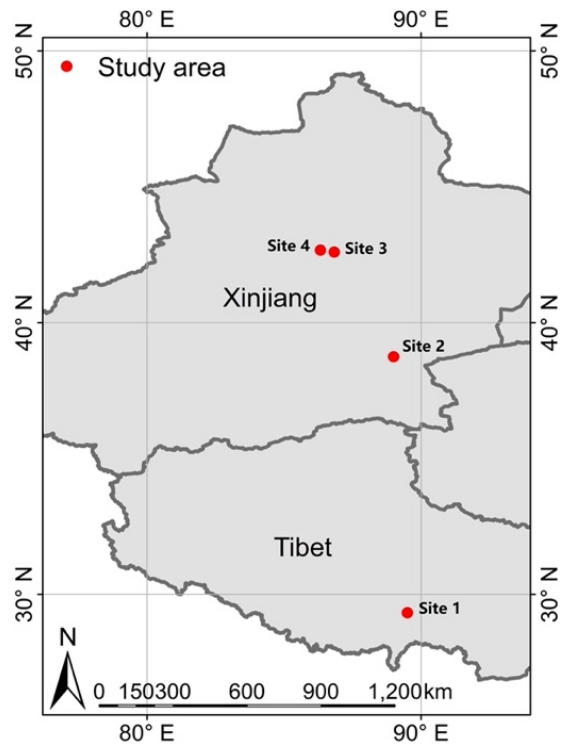
Figure 2. Geographical locations of four sites in this study.